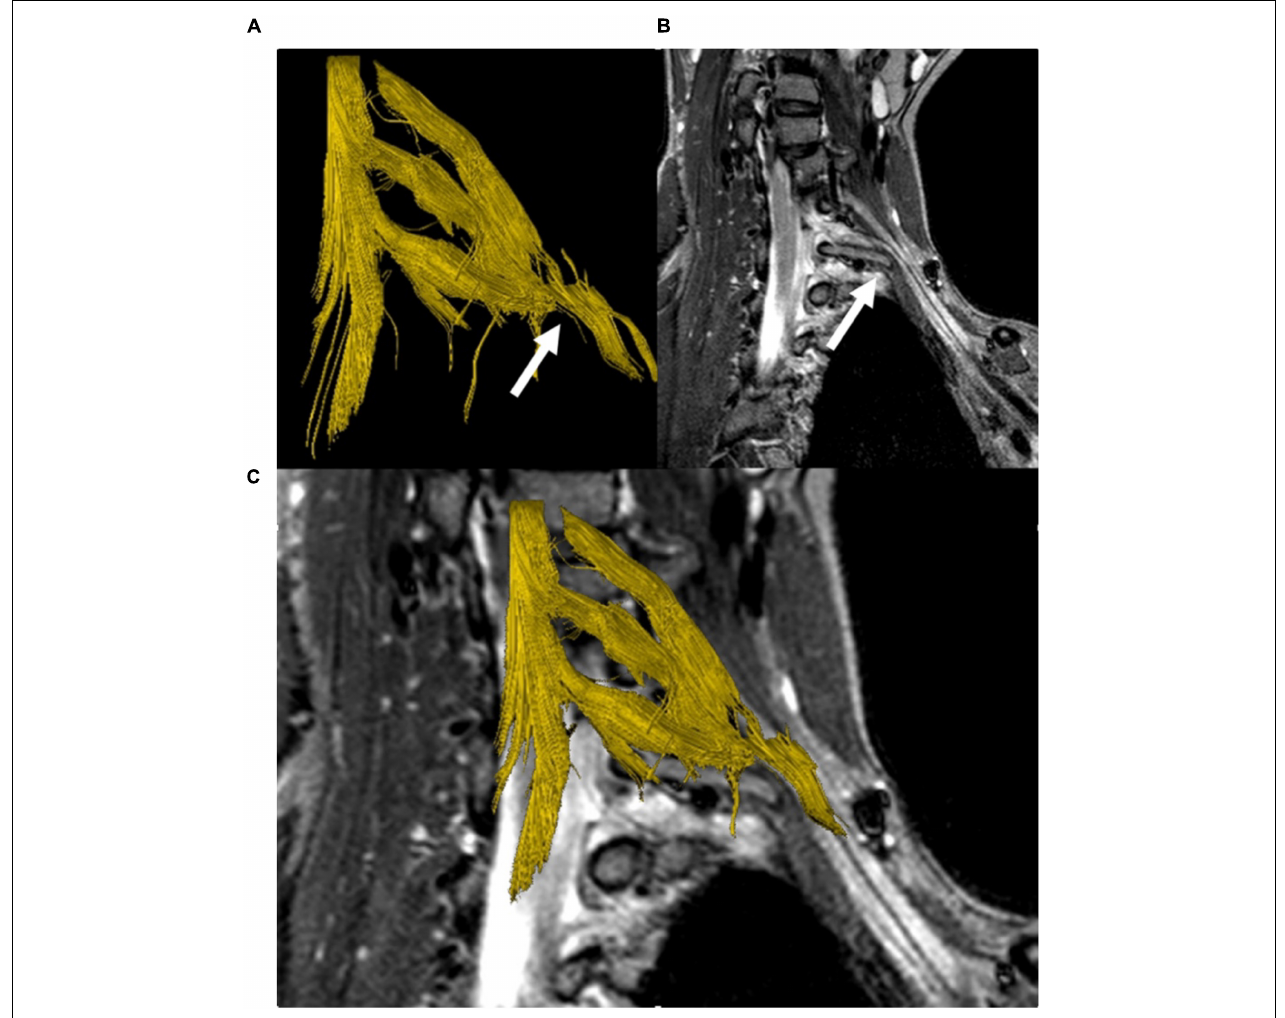
FIGURE 6 | DTI-based fiber tractography of the left brachial plexus in a patient with a cervical stump rib (C7). 3D fiber tract reconstruction of neuronal fibers generated from DTI data (A) , parasagittal STIR-MRI sequence demonstrating the peak apex of the stump rib with clear elevation and a shift of the lower brachial plexus segments (white arrow) (B) . Merging of the fiber track and anatomical series (C) demonstrates the cervical rib’s impact on the course of neuronal fibers, causing a plausible, visible correlation between the MRI and DTI/FT data